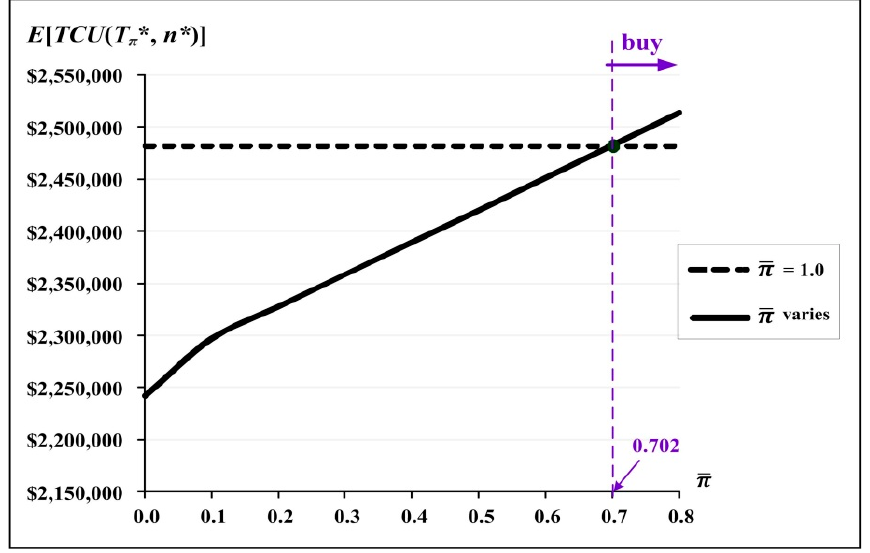
Figure 11. Effect of variations in 𝜋(cid:3364) on E [ TCU ( T π *, n *)] for managerial make-or-buy decision. Figure 11. E ff ect of variations in π on E [ TCU ( T